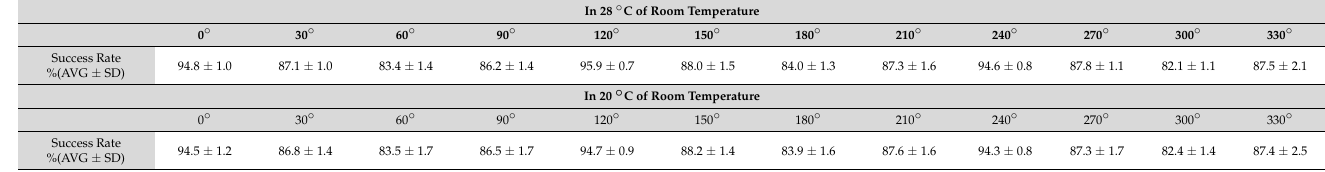
Table 2. Success rate of the identification in different downforce